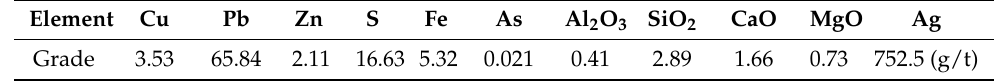
Table 1. Chemical analysis of the industrial copper–lead bulk concentrate (wt %).